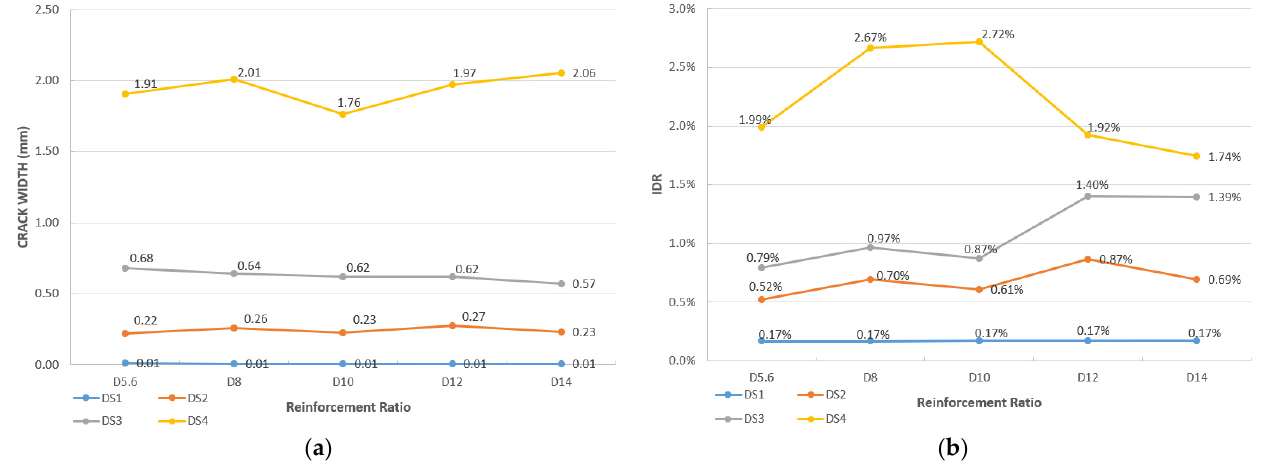
Figure 13. Correlation of damage states (DS) and the ratio of reinforcement ( ρ ) associated with: ( a ) crack width (mm); ( b ) IDR (%).